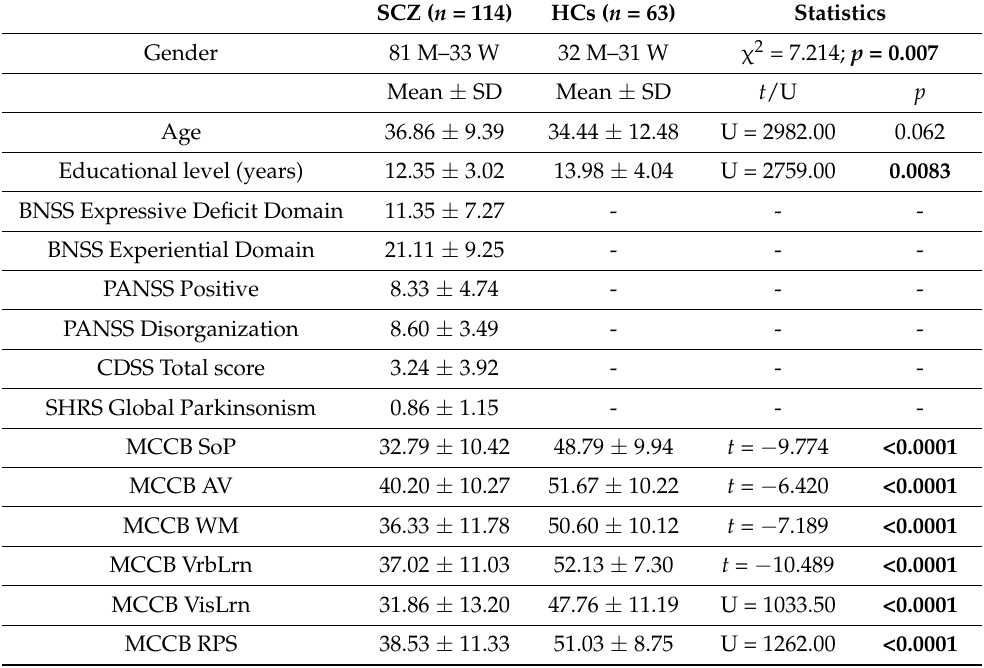
Table 1. Demographic characteristics, neurocognitive functions and illness related